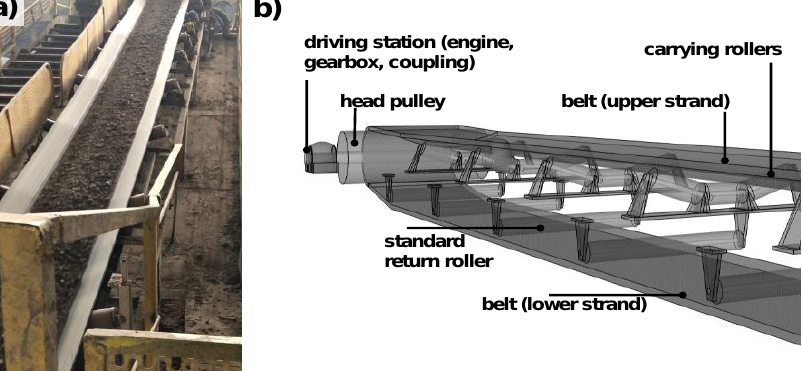
Figure 1. ( a ) Exemplary mining conveyor transporting copper ore, ( b ) main components of belt conveyor.